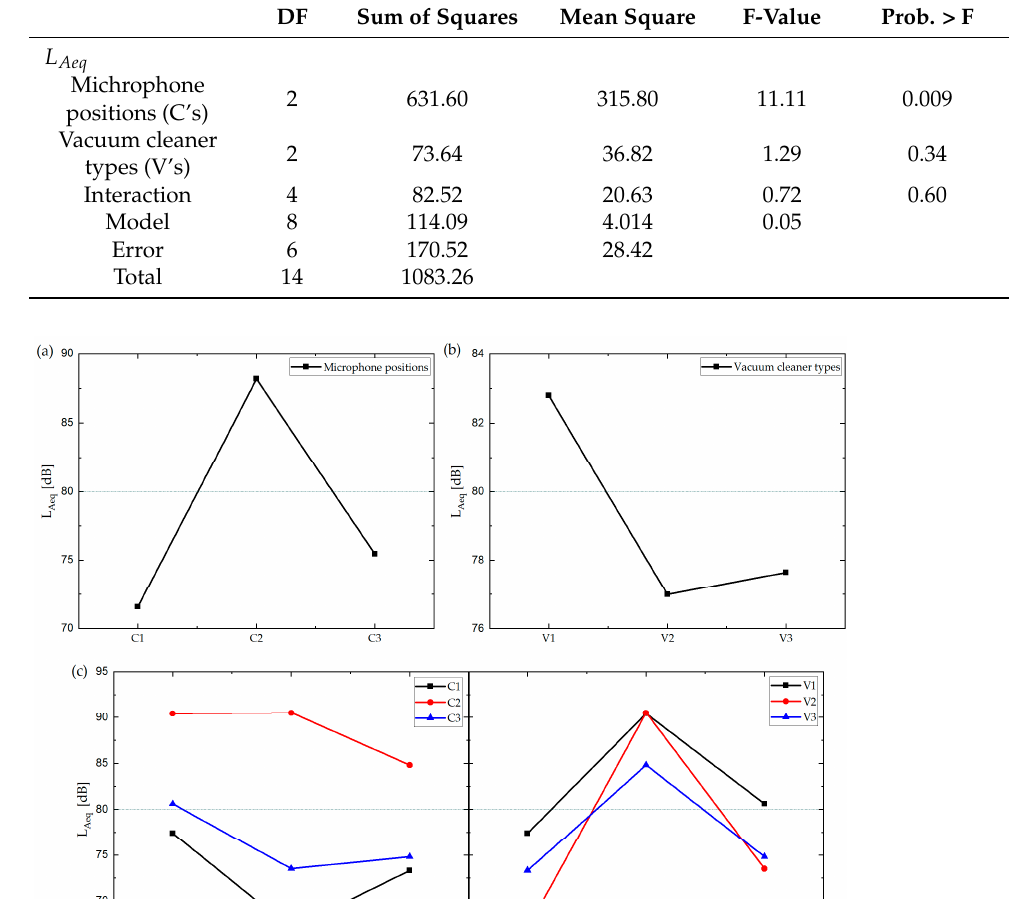
Table 3. Two-way ANOVA at a confidence interval of 95%.